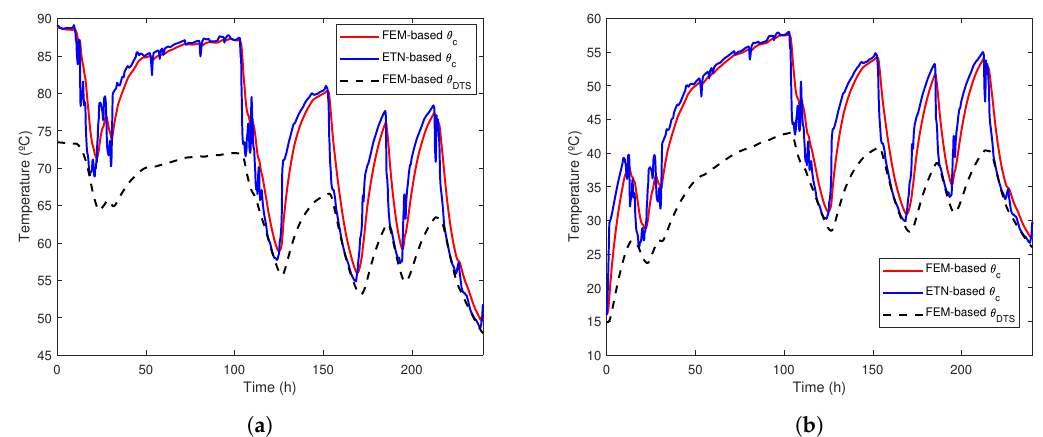
Figure 23. Estimation results for θ c in Cable 2R: ( a ) Case 1; ( b ) Case